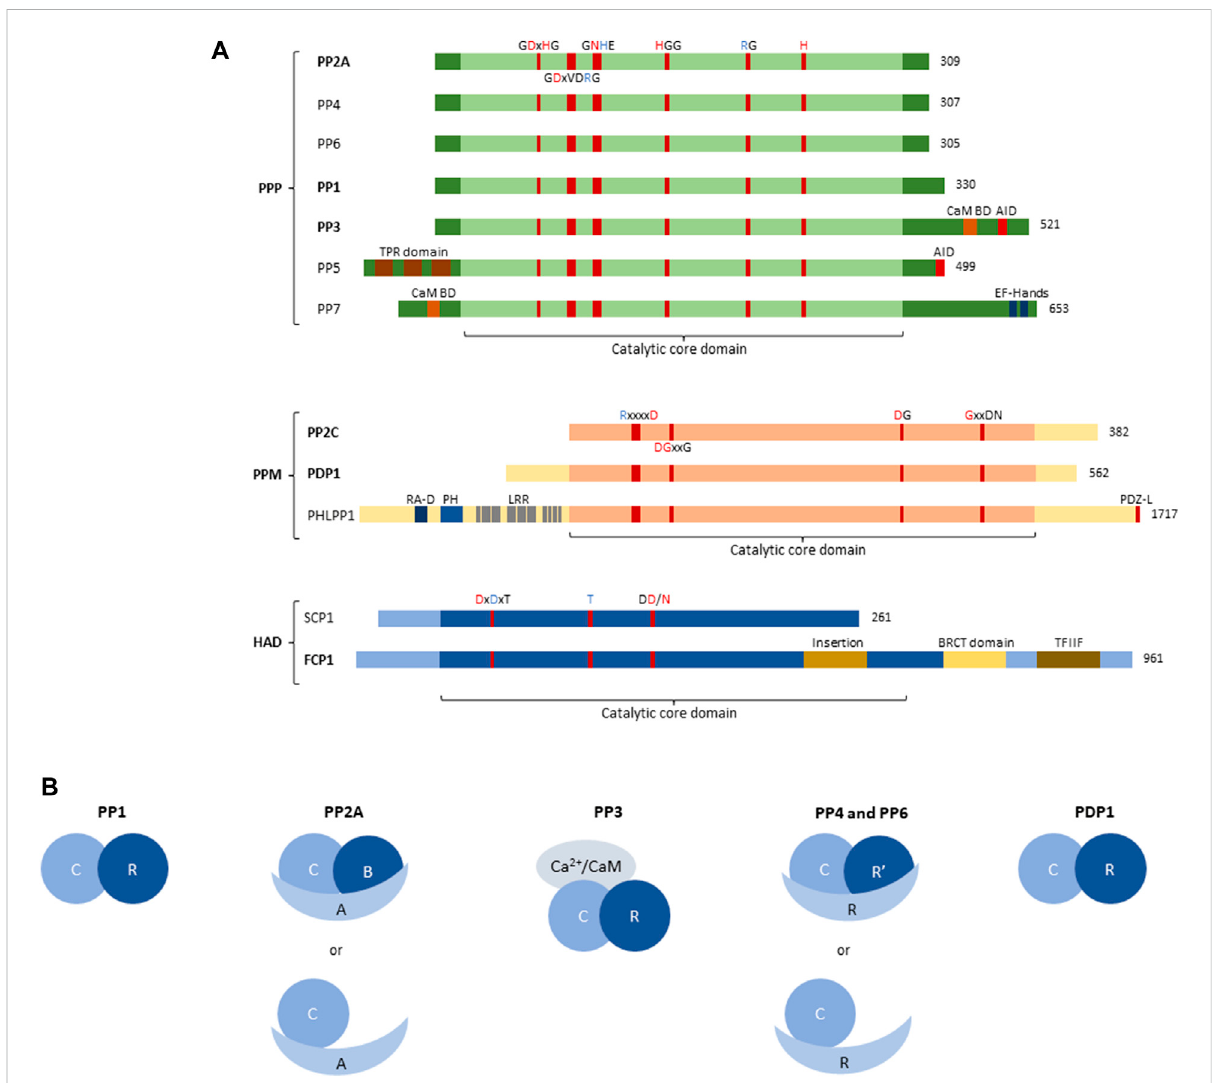
FIGURE 1 Structure of Protein Serine/Threonine phosphatase (PSP) superfamily. (A) Structural and domain organisation of the catalytic subunits of the mainPSPphosphatases.PSPscanbesubdividedintothreesubfamilies,thePhosphoproteinphosphatases(PPP),theMetal-dependentphosphatases (PPM), and the Haloacid phosphatases (HAD). The central part of each PSP phosphatase denotes the catalytic core domain, with relevant conserved amino acids and their position annotated. A red amino acid denotes involvement in metal binding, blue denotes phosphate binding. Additional structural and regulatory domains are indicated as follows: CaM BD, Ca 2+ -calmodulin binding domain; AID, auto-inhibitory domain; TPR domain, tetratricopeptide domain; EF-hands, canonical Ca 2+ -binding motif; RA-D, Ras-association domain; PH, Pleckstrin homology domain; LRR, leucine- rich repeat; PDZ-L, PDZ Ligand; BRCT domain, BRCA1-related C-terminal domain; TFIIF, transcription factor interacting helix. Bold indicates involvement in inborn genetic disease. (B) Organisation of PSP holoenzymes. PP1 forms a dimer between the catalytic subunit (3 isoforms), and regulatoryPIPs(~180).PP2ApredominantlyformstrimersbetweenthecatalyticC-subunit(2isoforms),thestructuralA-subunit(2isoforms),andthe regulatory B-subunit ( > 25 isoforms); however, dimers between the catalytic and structural subunit have also been described. PP3/calcineurin/PP2B forms trimers consisting of the catalytic subunit (3 isoforms), a Ca 2+ -binding regulatory subunit (2 isoforms) and Ca 2+ -calmodulin. PP4 and PP6, like PP2A,canformbothdimersandtrimers,withtrimers consistingofthecatalyticsubunit(1isoform each),astructuralsubunit(R,3isoforms each) and a regulatory subunit (R ′ , 2 and 3 isoforms, respectively), and dimers consisting of the catalytic and a structural subunit. PDP1 is the only non-PPP phosphatasethatforms aholoenzymewith oneregulatorysubunit(R,1isoform).C,catalyticsubunit;R, scaffold orregulatorysubunit;R ′ ,regulatory subunit; A, scaffold subunit of PP2A; B, regulatory subunit of PP2A; CaM,